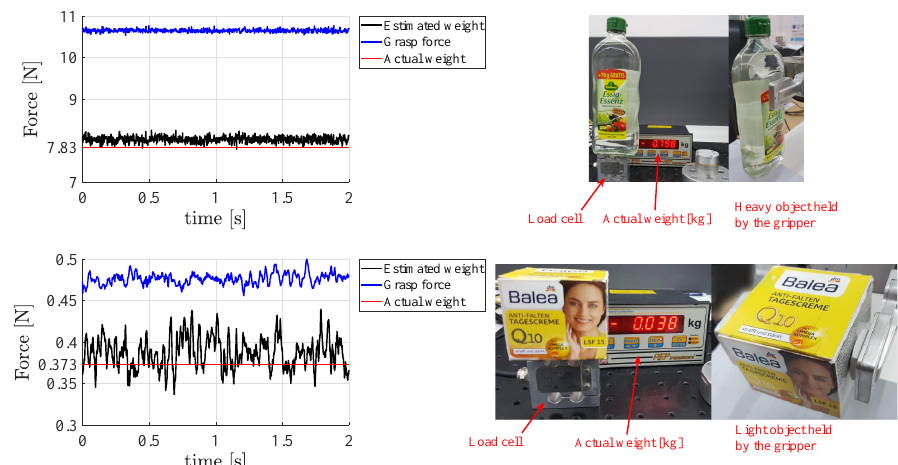
Figure 19. Third experiment: Assessment of sensor sensitivity ( bottom ) and dynamic range ( top ).